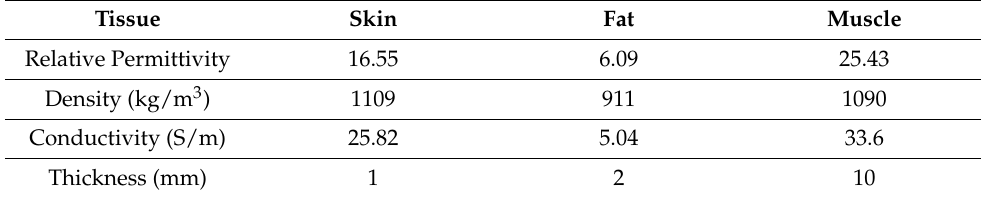
Figure 2. A single DRA element above the body phantom.